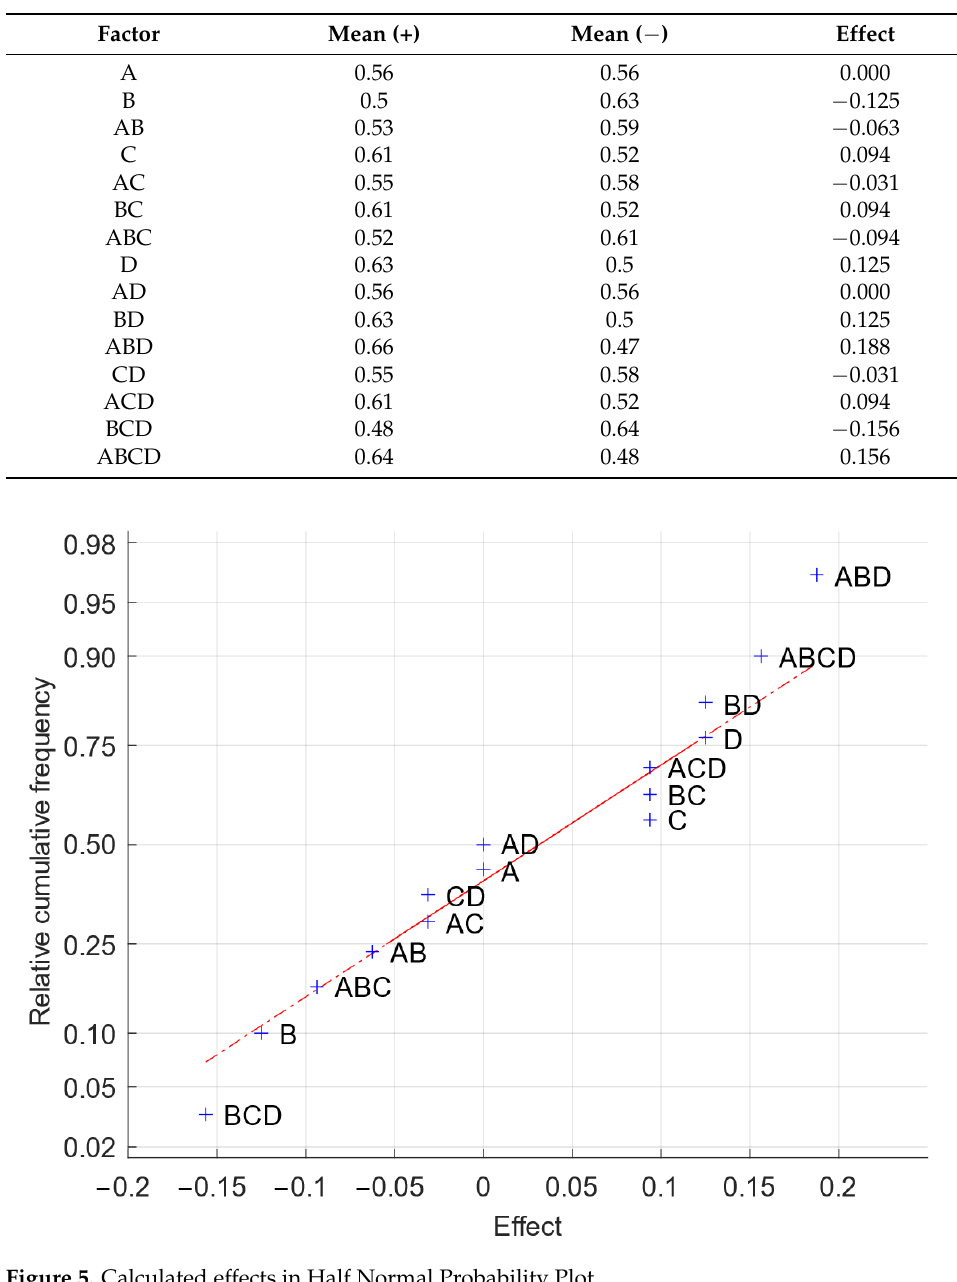
Table 6. Effects of factors and interactions for functioning cells.